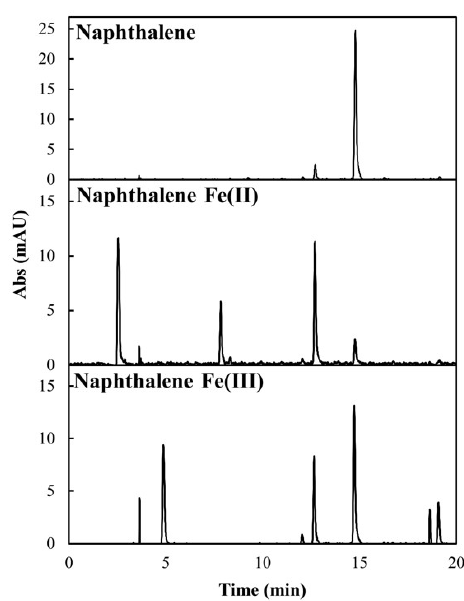
Figure 6. HPLC of resulting reaction between naphthalene and water-soluble iron. Phthalic acid at 12.5min, phthalic anhydride at 7.5min, naphthol at 15min, and naphthalene at 20min. The column uses a C18 stationary phase on beads with an 80Å pore